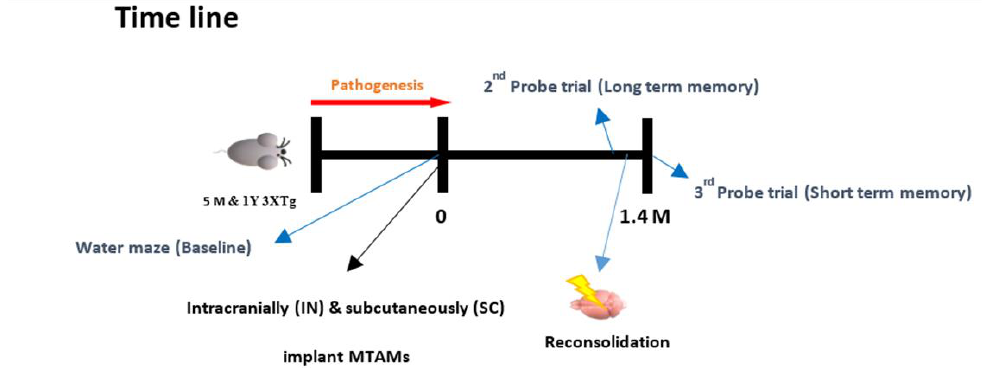
Figure 10. Timeline leading up to the test of the short-term and long-term memory test of the MWM. The procedure involves the training of the mice from day 1–6 based on distal spatial cues to locate the platform where the mice are placed in different random quadrant for it to search for the platform; assessed by the escape latency and time in quadrants in which submerged platform is located in. With these values as the baseline, a probe test was carried out at 1.4 months later where the submerged platform was removed and the above-mentioned tests were repeated. Within 24 h of conducting the long-term memory test, a reconsolidation process was carried out by replacing the submerged platform and repeating the steps outlined in the baseline section. After 24 h, another probe test was carried out again by removing the submerged. The escape latency and time in quadrant at this time will form the basis for the short-term memory [48].